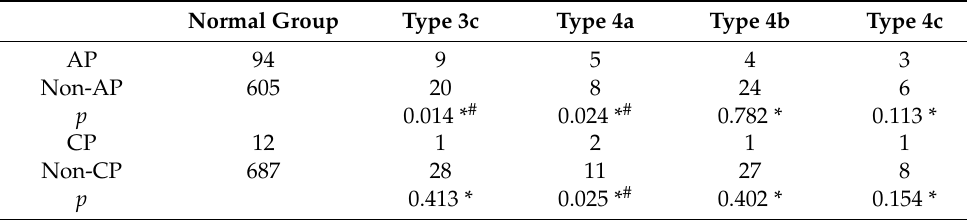
Table 3. Correlation analysis between AP, CP, and type 3c, type 4.